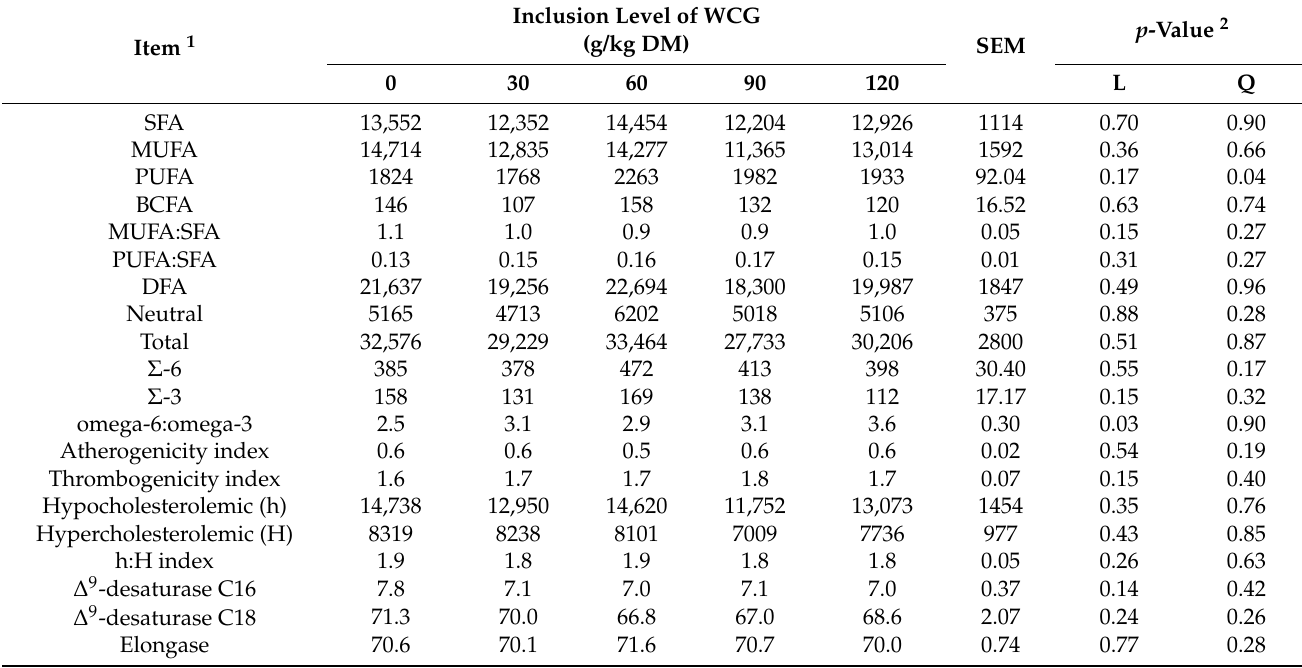
Table 5. Fatty acid groups, sums ( Σ ), ratios, and nutritional quality of lipid fraction (mg/kg of meat) of the Longissimus lumborum muscle of feedlot lambs fed diets with whole corn germ